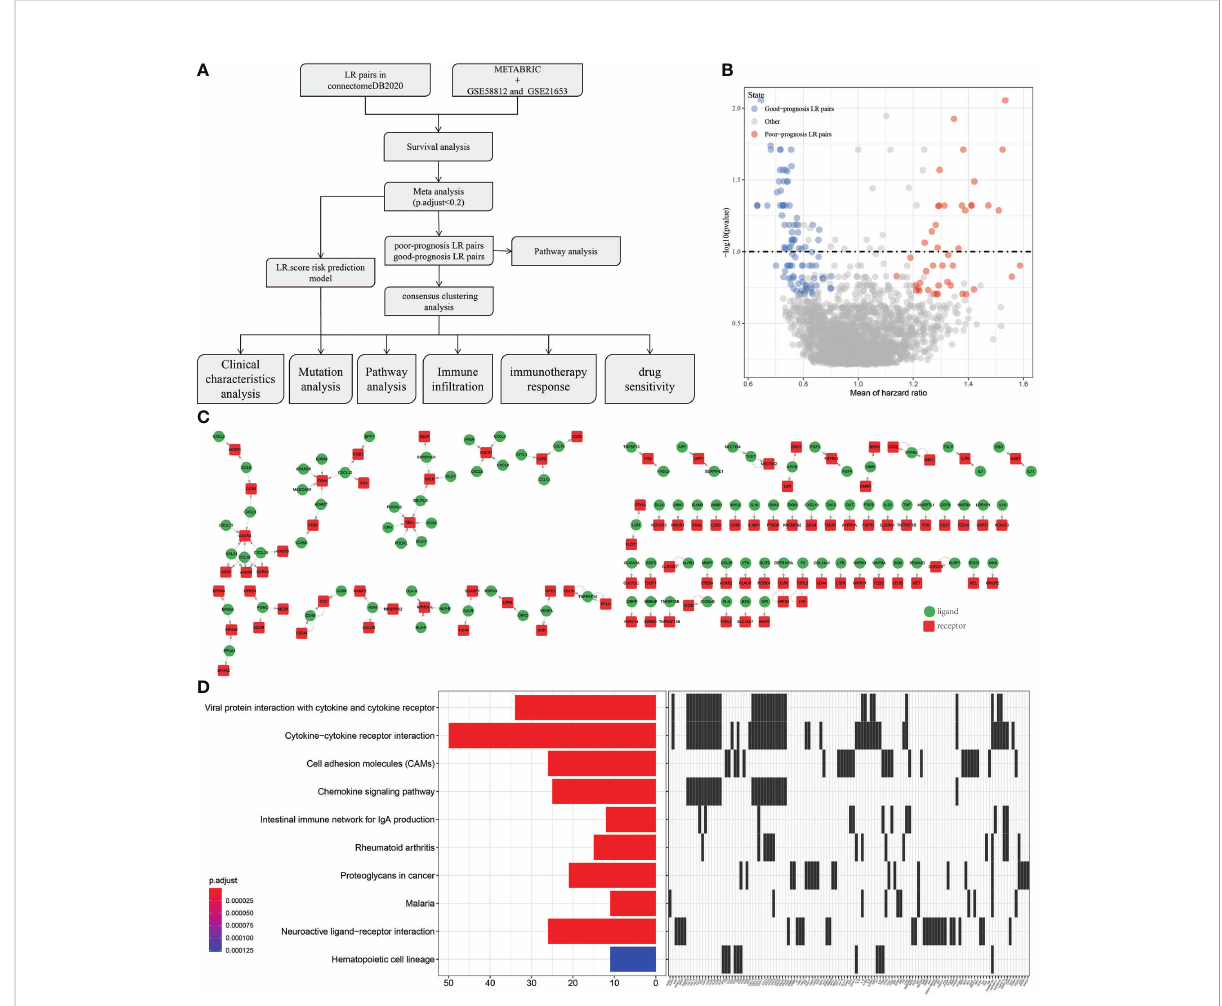
FIGURE 1 Screening of LR pairs related to prognosis. (A) Outline of the process for this study. (B) Prognostic volcano maps of 145 LR pairs. (C) The interactive network diagram of 145 LR pairs. (D) 10 most highly enriched KEGG pathways of 145 LR